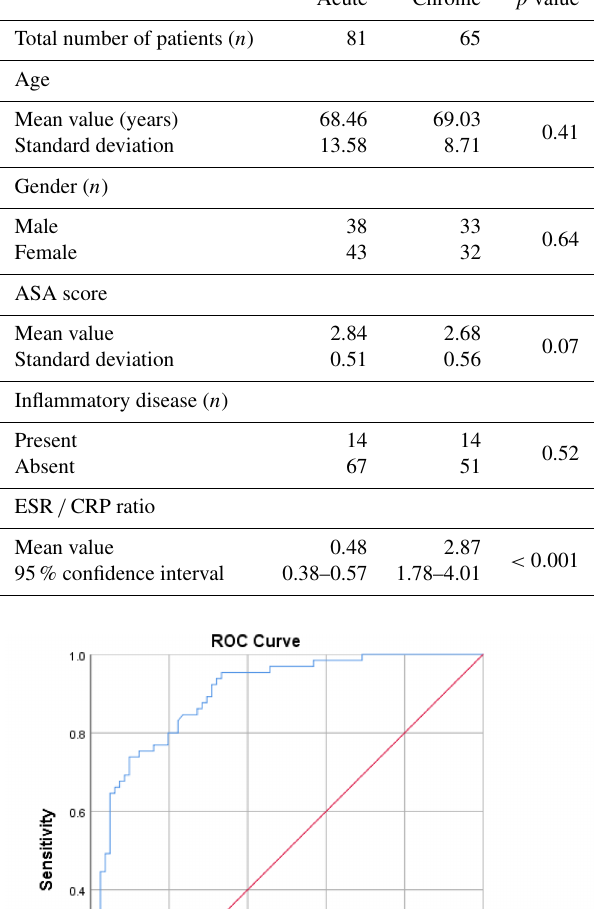
Table 1. Summary statistics of acute vs. chronic PJI.